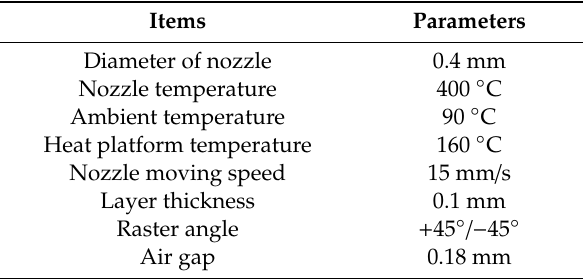
Table 1. Parameters of fused deposition modeling (FDM) processing.